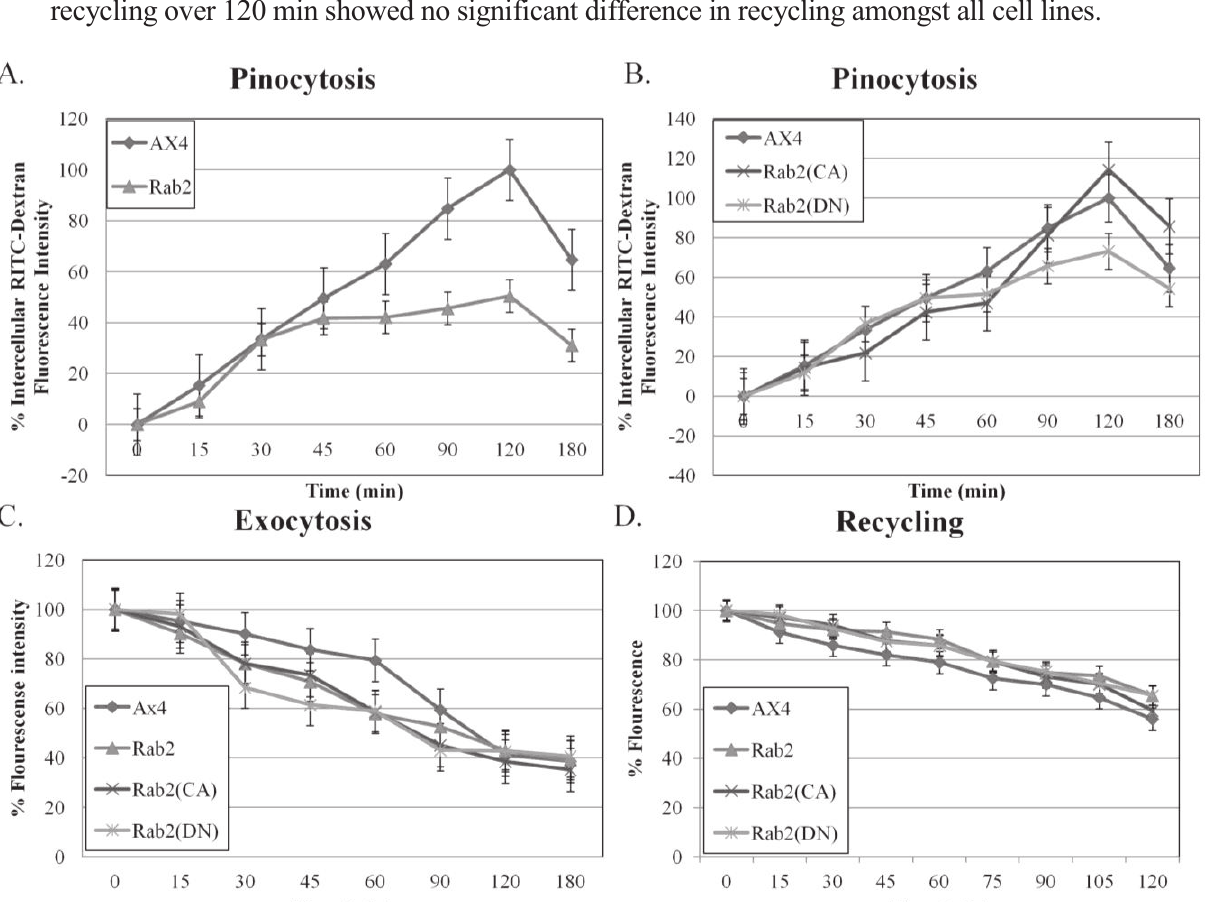
Figure 2. Pinocytosis and Exocytosis are altered in DdRab2 over-expressing, DdRab2(CA), and DdRab2(DN) cells. ( A , B ) Graphical representation with standard error of the rate of pinocytosis in Rab2 over-expressing, Rab2(CA), and Rab2 (DN) cell lines compared to the parent strain AX4 cells. Data for pinocytosis, exocytosis, and recycling is the average of three independent experiments with a p -value > 0.05. Cell lines were incubated in HL5 medium containing RITC-dextran (100 mg/mL) over 180 min. Data are presented as relative fluorescence to AX4 which is considered 100% RITC-dextran internalization at 120 min. At the indicated times, cells were washed by centrifugation and accumulated RITC-dextran was measured using a fluorimeter. ( A ) The intercellular fluorescence representing pinocytosis in the Rab2 over-expressing cell line is decreased compared to AX4 cells, however, this decrease was not significantly significant; ( B ) The intercellular fluorescence representing pinocytosis in the Rab2(CA), and Rab2(DN) cell lines. The Rab2(CA) cell line shows a slight increase in pinocytosis at the 120-min time point while the Rab2(DN) cell line shows a slight decrease in the rate of pinocytosis after 120 min compared to the AX4 cells (increase and decrease not statistically significant); ( C ) Graphical representation with standard error of the rate of exocytosis. After 180 min of RITC-dextran accumulation, cells were washed and re-suspended in growth medium. At the indicated times, the remaining intracellular RITC- dextran was measured. Rab2, Rab2(CA), and Rab2(DN) cells did not show a significant change in intercellular fluorescence representing exocytosis; ( D ) Graphical representation with standard error of RITC-Dextran recycling over 120 min showed no significant difference in recycling amongst all cell